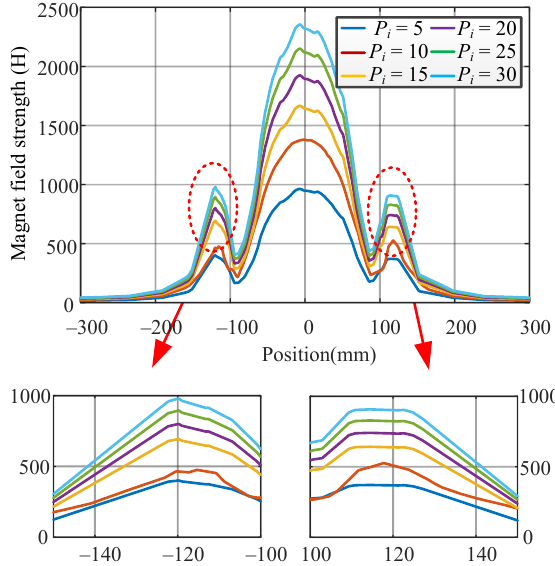
Figure 12. Magnetic field strength curves of shields with different input powers.